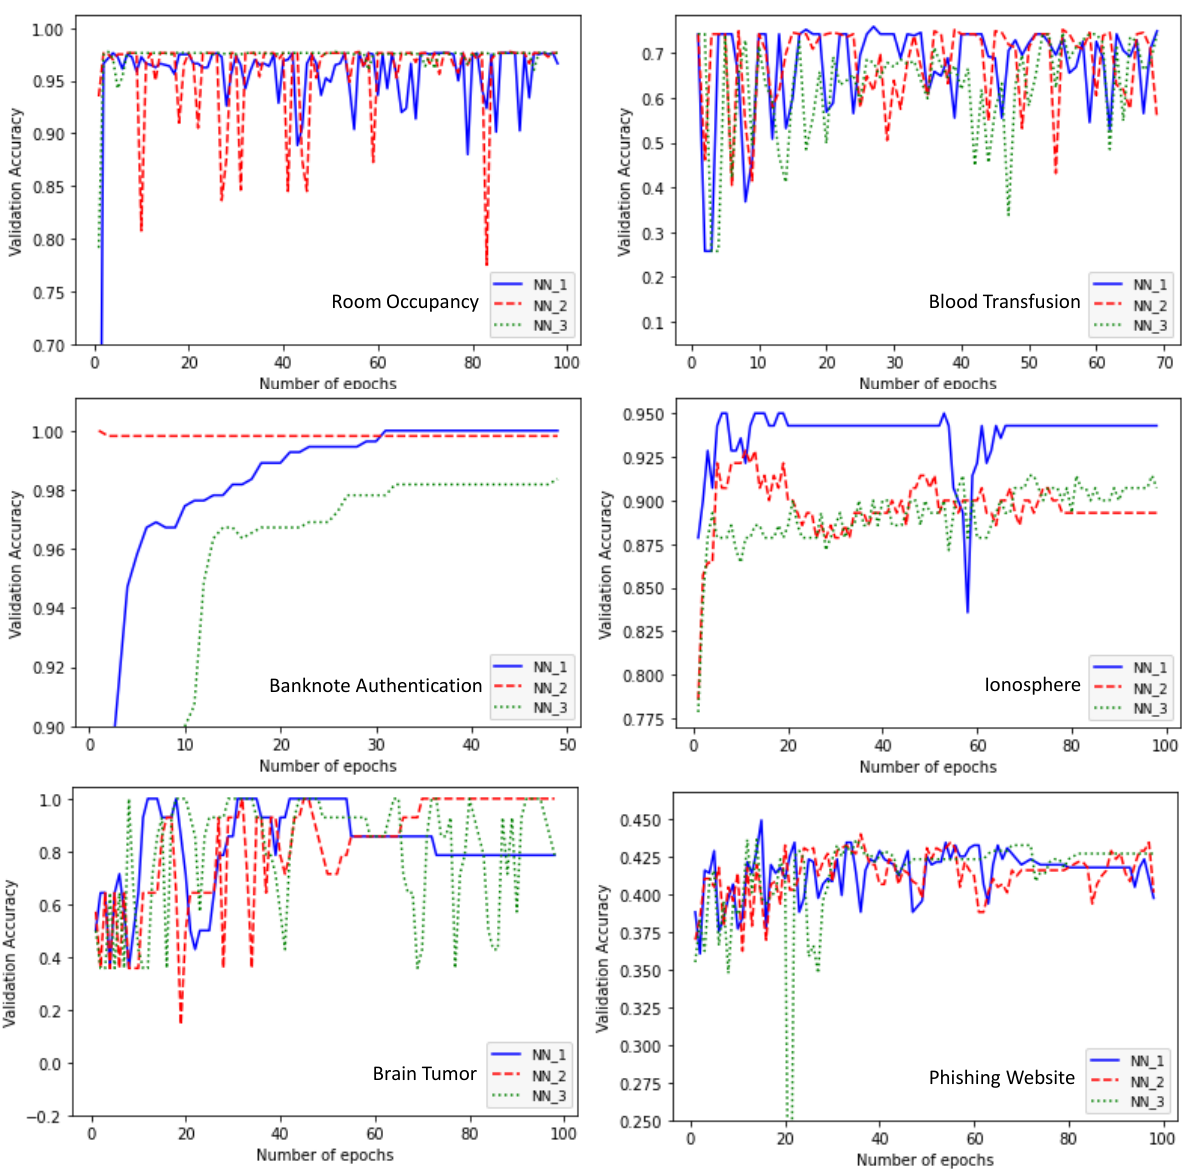
Figure 7. (First Experiment) Classification (i.e., validation) accuracy evaluated on the testing data as a function of the number of training epochs obtained by the three best neural network models: NN_1, NN_2, and NN_3 (datasets: room occupancy, blood transfusion, banknote authentication,